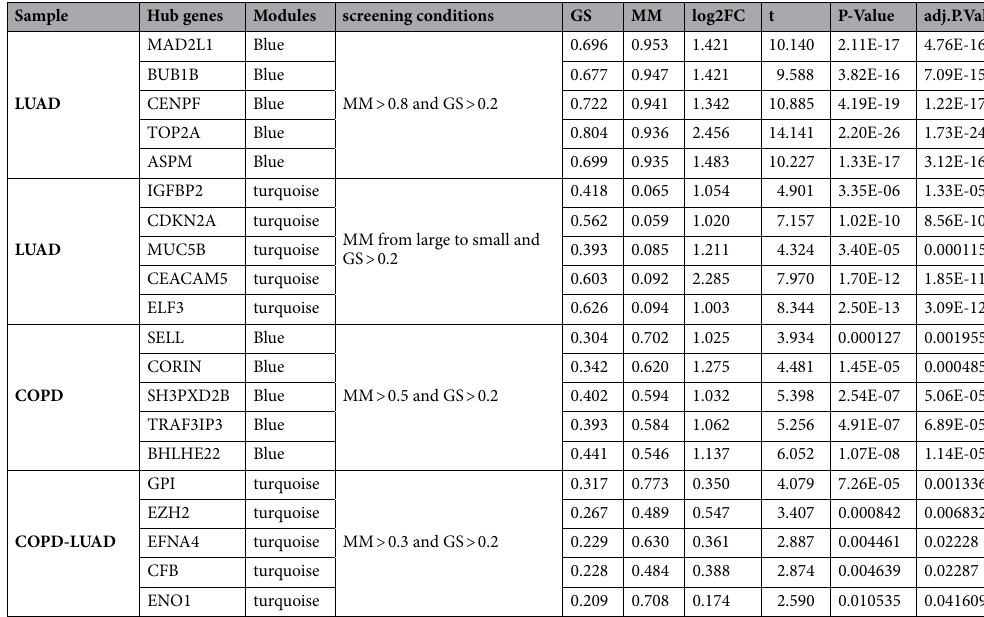
Table 1. Hub Genes in Target Modules. Abbreviations: COPD = Chronic obstructive pulmonary; LUAD = lung adenocarcinoma; GS = Gene significance; MM = module membership; log2FC = log2FoldChange; adj.P.Val = adjust